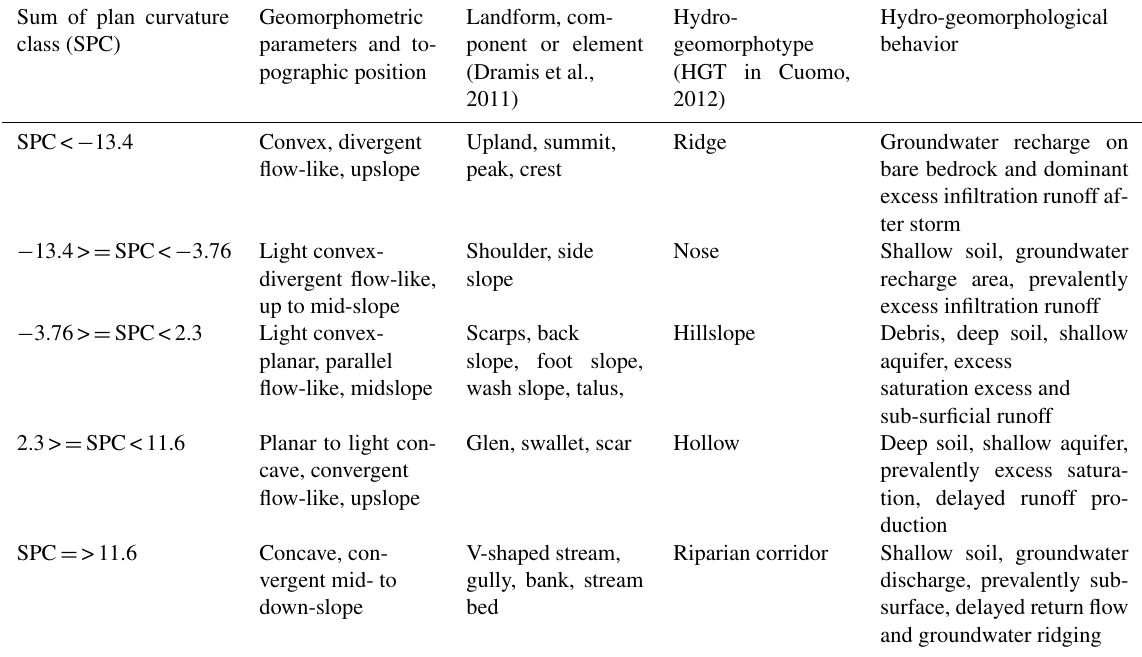
Table 2. Geomorphometric classification, geomorphological correspondence, hydro-geomorphotype definition and hydro-geomorphological behavior for each hydro-geomorphotype.